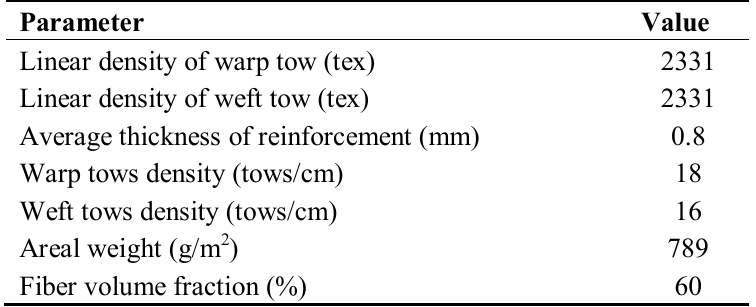
Table 2. Reinforcement and composite specifications.